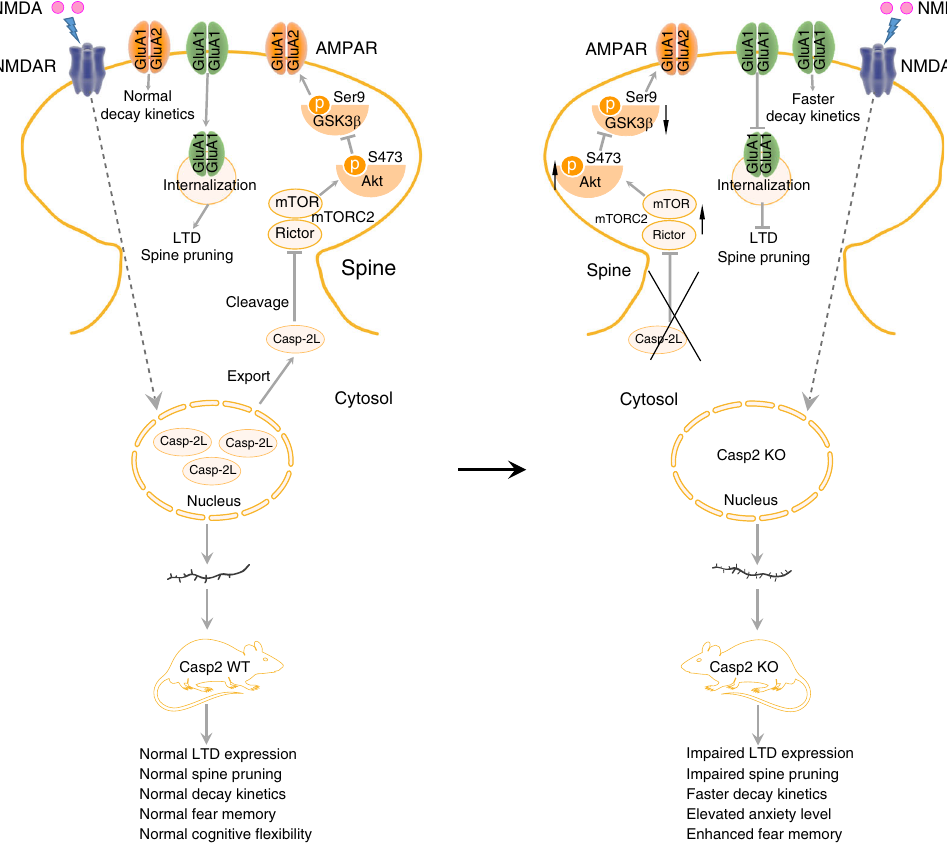
Fig. 7 A model of caspase-2 mediated synaptic plasticity and cognitive fl exibility. Under basal condition, the majority of caspase-2L is localized in the nucleus. Upon NMDA stimulation, caspase-2L is exported from the nucleus into dendrites, where it mediates the cleavage of mTORC2 scaffold protein Rictor. Decreased mTORC2 level reduces the Akt activity but increases the GSK3 β activity, therefore inducing AMPAR internalization and LTD. Caspase-2 de fi ciency impairs LTD and spine pruning, increases GluA1 level, causes faster decay kinetics, elevates anxiety level, and impairs cognitive fl